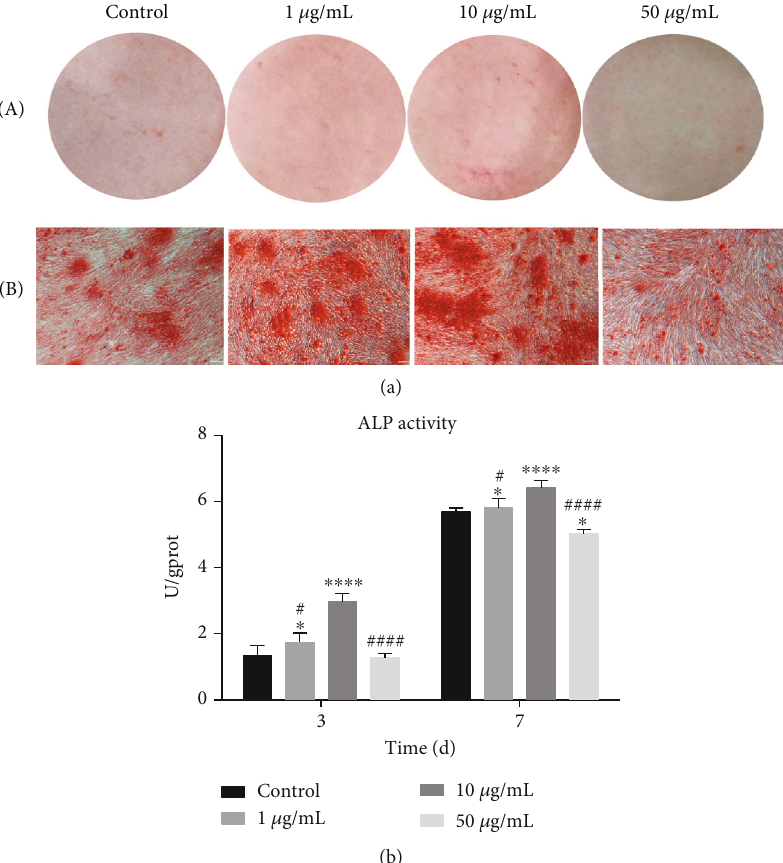
Figure 4: SHEDs were cultured in the osteogenic induction medium containing GOQDs. Osteogenic di ff erentiation was detected by (a) alizarin red S staining for 14 days: (A) optical photos and (B) microscopic images. (b) ALP activity after 3 and 7 days. Scale bar, 100 μ m. ∗ p < 0 : 05 , ∗∗ p < 0 : 01 , ∗∗∗ p < 0 : 001 , and ∗∗∗∗ p < 0 : 0001 vs. the control group. # p < 0 : 05 , ## p < 0 : 01 , ### p < 0.001, and #### p < 0 : 0001 vs. the 10 μ g/mL GOQD